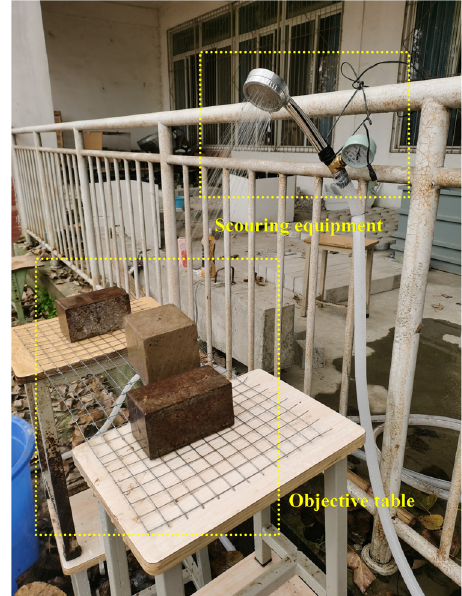
Figure 10: Self - made sprinkler.